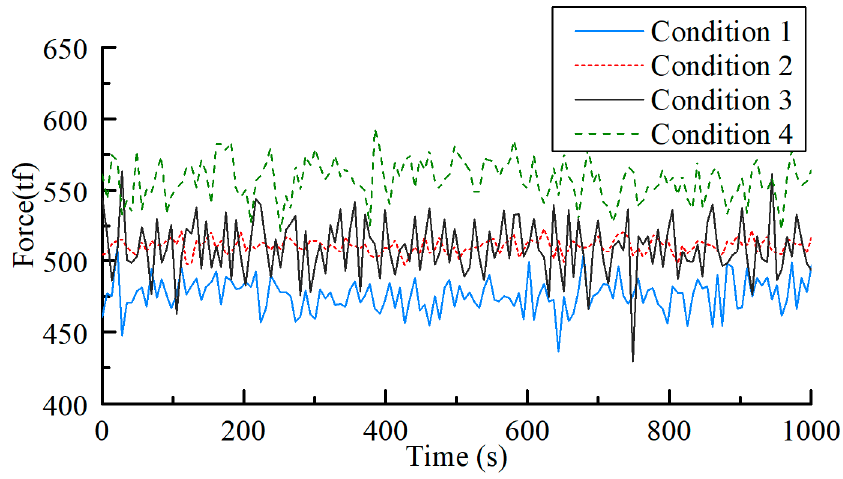
Figure 12. The interacting forces during transport process.